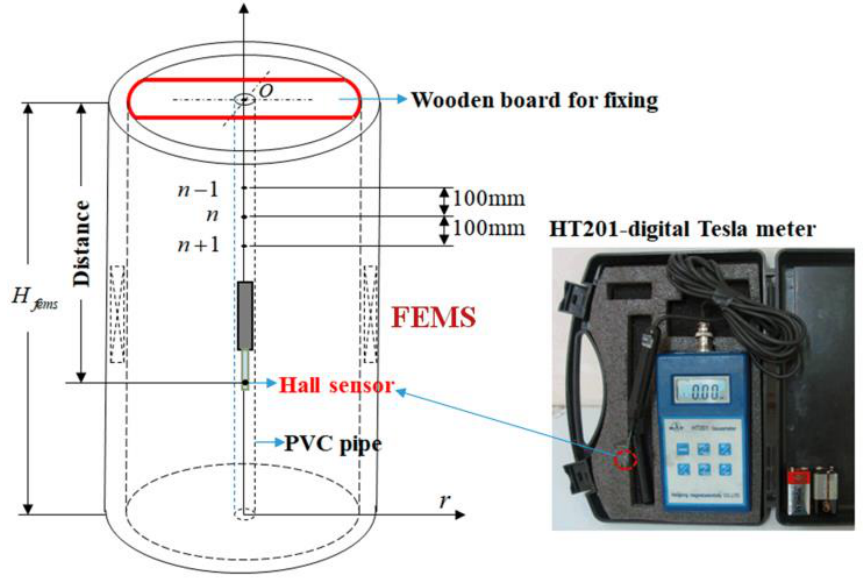
Figure 9. Measuring method and device for FEMS.